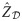
Inference on the Lac-Gfp model.A: Development of the estimation of the Bayesian evidence using the estimation based solely on the dead points Z^D, the estimate approximation from the live points Z^L and the estimation that uses both Z^tot. The corresponding standard errors are indicated as the shaded areas. B: Estimate of the current variance estimate σ^tot2m and the lower bounds for the lowest achievable variance σ^min2. C: The acceptance rate of the LF-NS algorithm for each iteration (blue) and the cumulative time needed for each iteration in hours (red). The computation was performed on 48 cores in parallel on the Euler cluster of the ETH Zurich. D: Marginals of the inferred posterior distributions of the parameters based on one simulated trajectory. The blue lines indicate the parameters used for the simulation of the data.